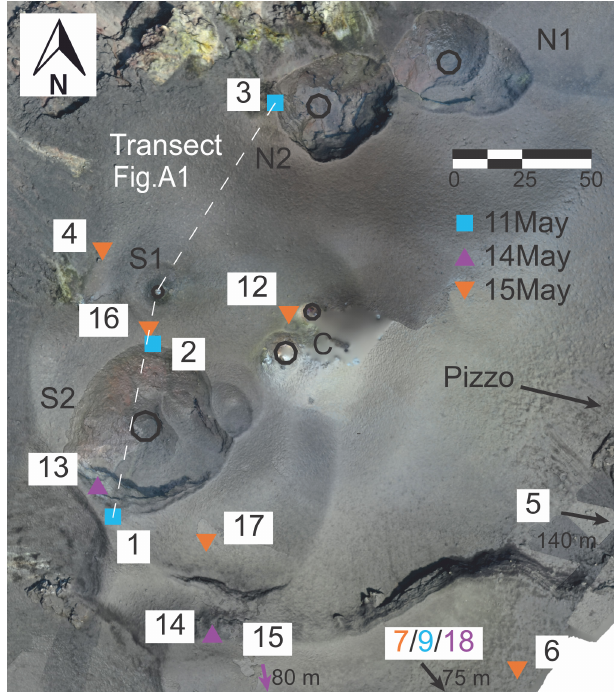
Figure 2: Crater Terrace of Stromboli volcano, Italy, as in May 2019 [Schmid et al. 2021]. Sensor locations were located in a georeferenced orthomosaic via georeferenced images taken during the placement of the senor. The colour of symbols indi- cates on which day the sensors were operational. The dashed white line marks a transect that can be seen in Figure A1. Refer to Table 1 for all vent to sensor